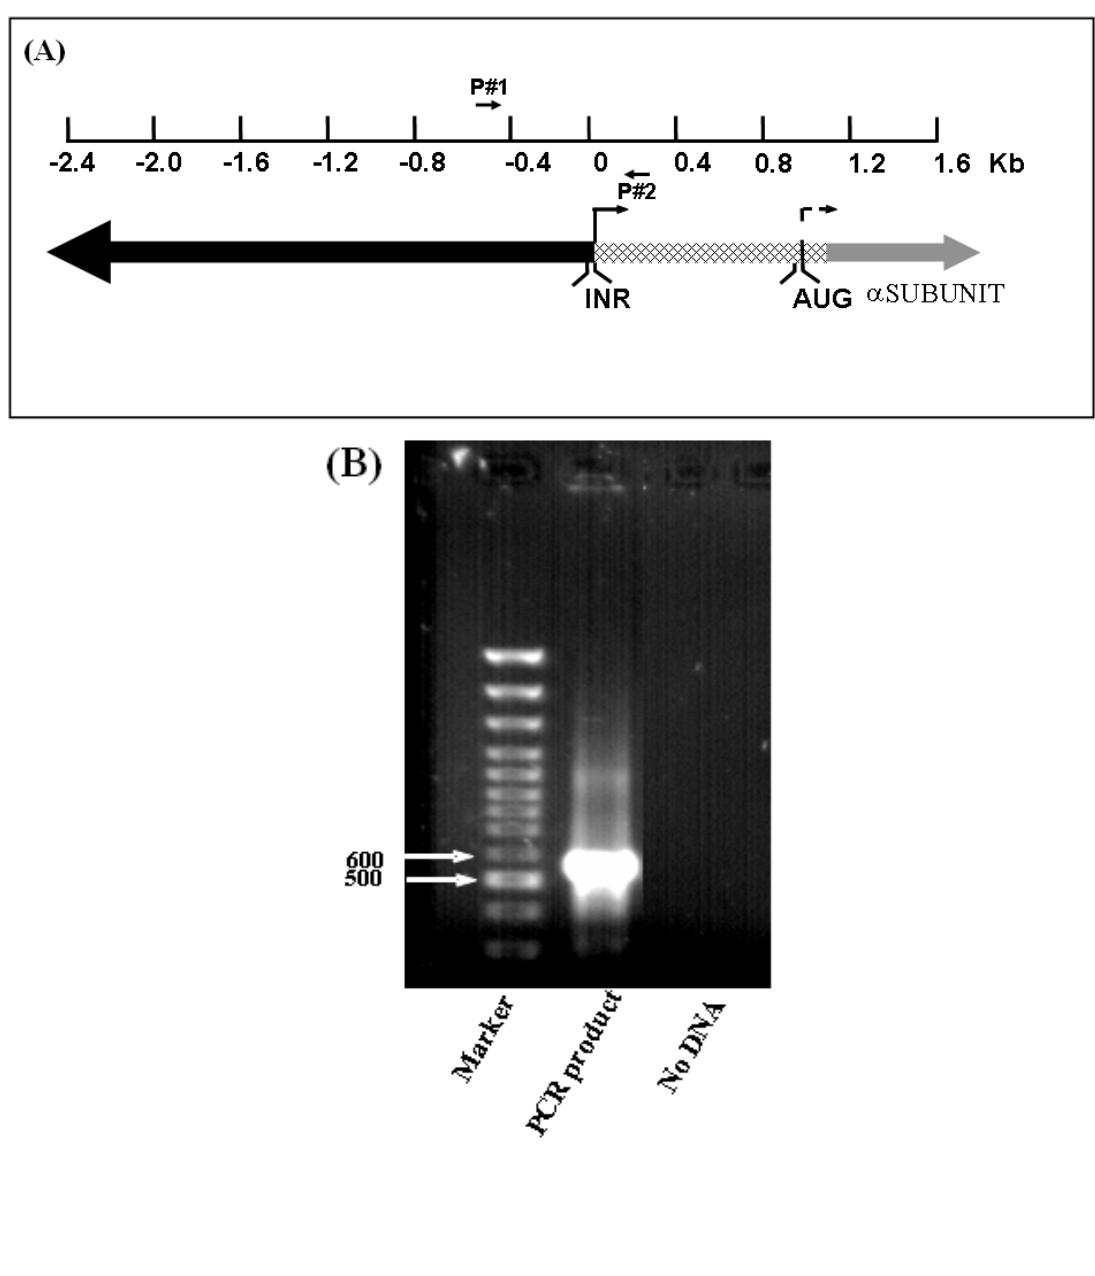
Figure 1. IGF-IR promoter. (A) Schematic representation of the IGF-IR promoter region [5]. The initiator (INR) element is denoted by an arrow. The coding region, starting with the AUG codon, is shown in gray. The translation start site is denoted by a dashed arrow. The 5’-flanking region is denoted by a black bar, and the 5’-untranslated region (UTR) is represented by a dotted bar. The location of primers (P#1 and P#2), employed to amplify the proximal promoter is indicated. (B) PCR amplification of the human IGF-IR promoter. The PCR reaction was performed using a biotinylated antisense primer, as described under Materials and Methods section, and 4  L of the biotinylated PCR product was loaded on a 1% agarose gel. A PCR reaction without DNA served as negative control. A 100-bp DNA ladder was used as a M.W.